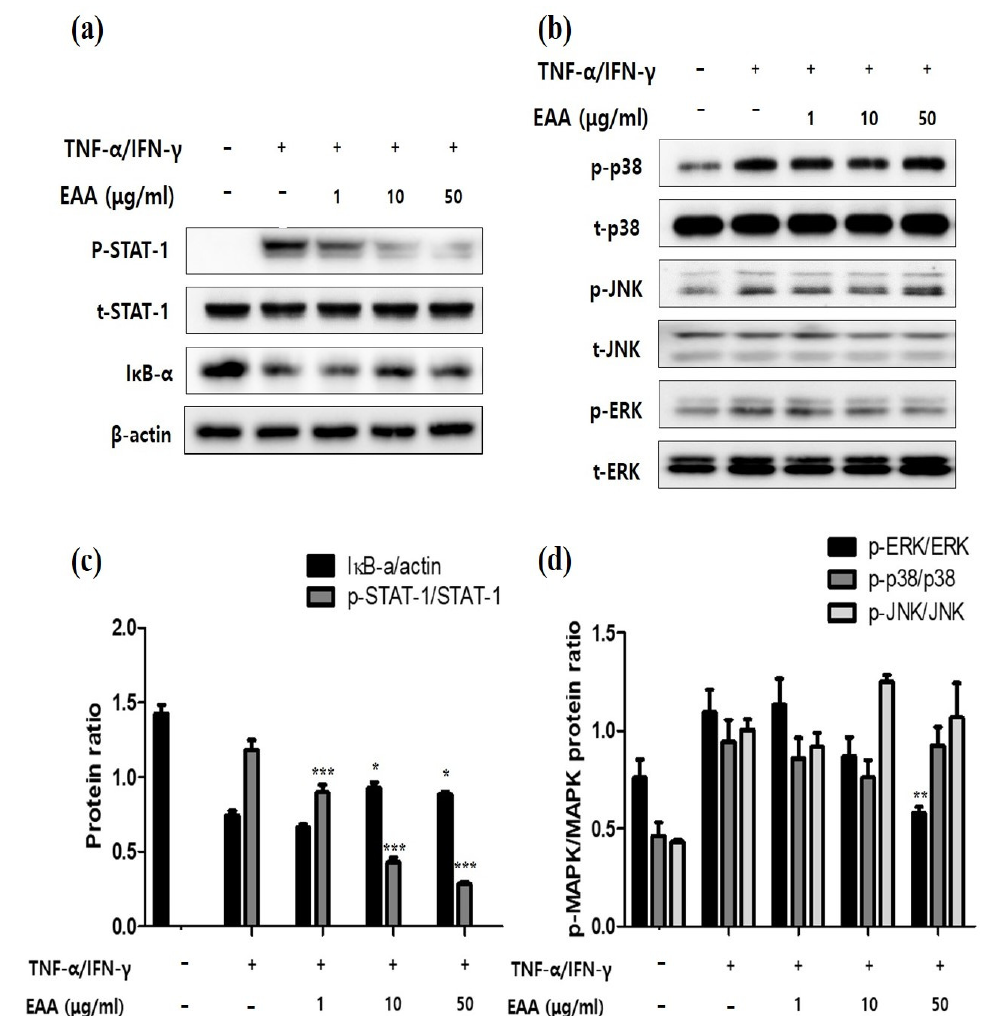
Figure 3. Inhibitory effects of EAA on MAPKs and STAT-1 signaling pathways in TNF- α /IFN- γ - stimulated HaCaT cells. HaCaT cells were pre-incubated with EAA for 1 h and then exposed to TNF- α /IFN- γ (10 ng/mL each) for 30 min. ( a , c ) Effects of EAA on STAT-1 activation and I κ B- α degradation. ( b , d ) Effects of EAA on MAPK phosphorylation in HaCaT cells. Levels of phosphorylation and expression were determined by western blotting using the indicated antibodies. Blots were normalized to the total protein or β -actin. Results are expressed as a mean percentage in the treated cells compared to the control (solvent) ± S.E. of three independent experiments performed in triplicates. * p < 0.05, ** p < 0.01, and *** p < 0.001 compared with the TNF- α /IFN- γ -treated control group.